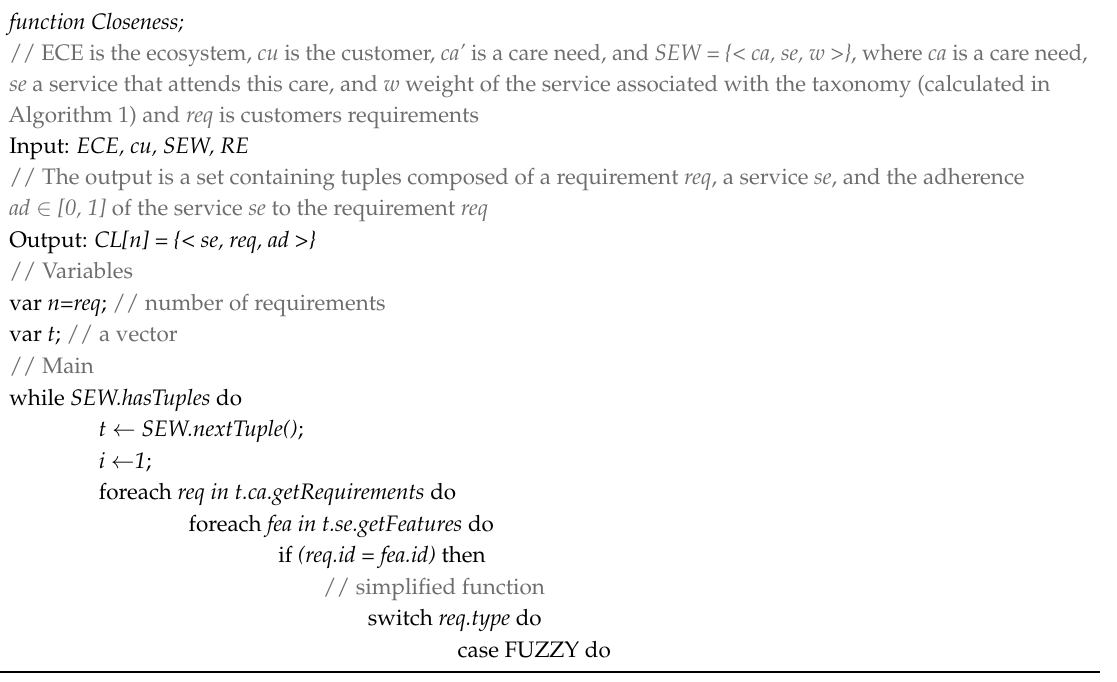
Algorithm 2 Closeness Adherence